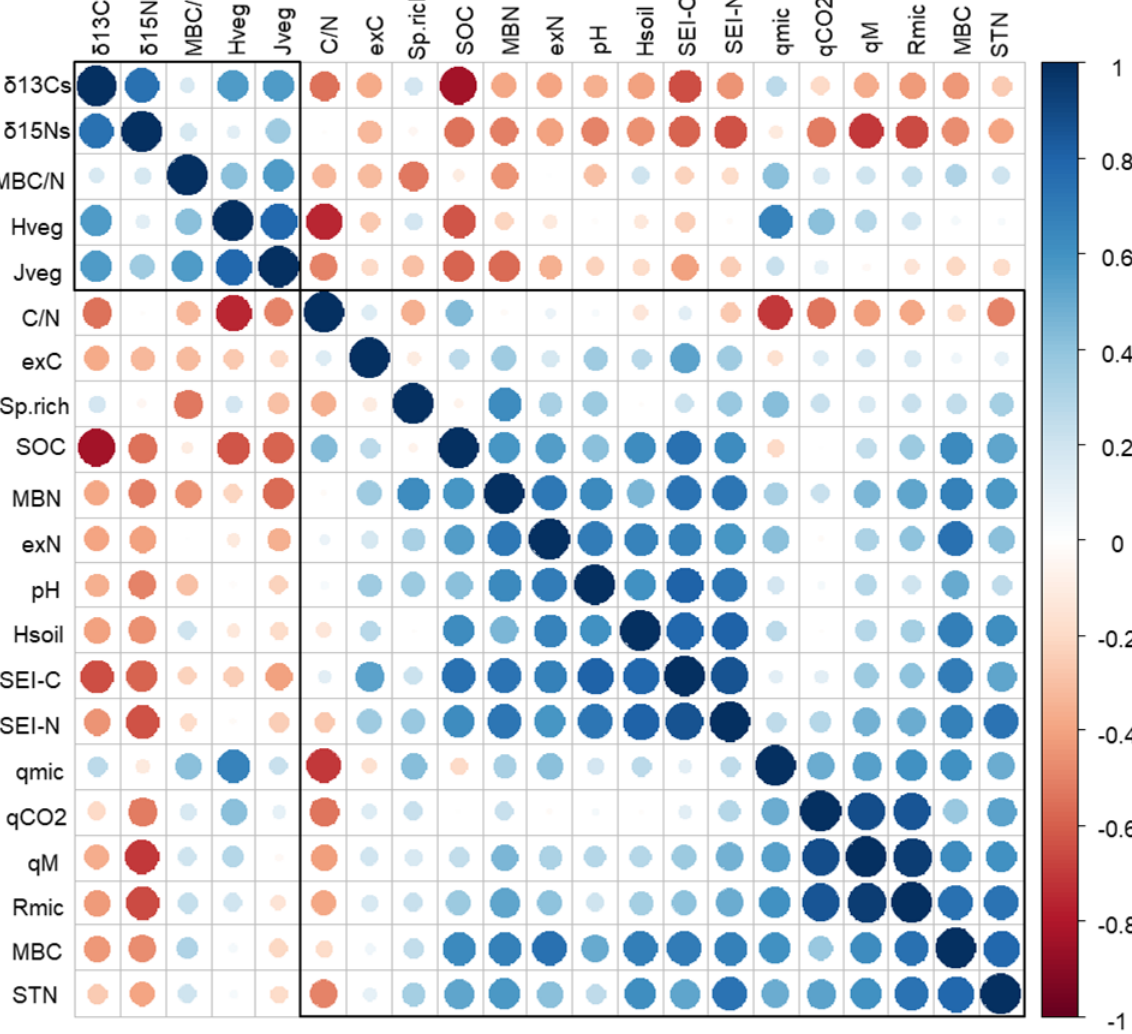
Figure 7. Spearman correlation matrix. Data are clustered according to the similarity in patterns of correlation coefficients.